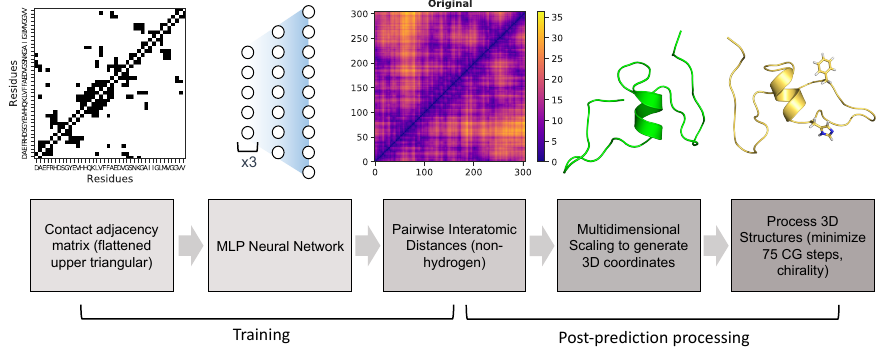
Figure 3. Pipeline of MLP neural network training and post-prediction processing. Post-prediction processing The predicted output data (the flattened upper triangles of the pairwise interatomic distance matrices) were first transformed into symmetric pairwise interatomic distance matrices. These were then transformed into 3D coordinate data using the multi-dimensional scaling (MDS) function from the scikit-learn python module and MDtraj [49] to generate PDB structures (Figure 3). Chimera [50] was then used to add hydrogens to predicted PDB structures, which were then further processed to remove inaccurate chiral predictions. If more than half of C α centers were inaccurately predicted as R chiral centers (D-amino acids instead of L-amino acids), this indicated that the MDS procedure (which is reflection-invariant) predicted a reflection of the true coordinates. This was mitigated by reflecting all coordinates over the y-axis for predictions exhibiting an R ratio greater than 1. If fewer than half of α -carbons exhibited R chiral centers, reflecting coordinates was unnecessary. Instead, Chimera was used to switch side chain coordinates and the α -hydrogen for all inaccurately predicted C α chiral centers. After checking for correct chirality for each residue, all conformations were further minimized for 75 conjugate gradient